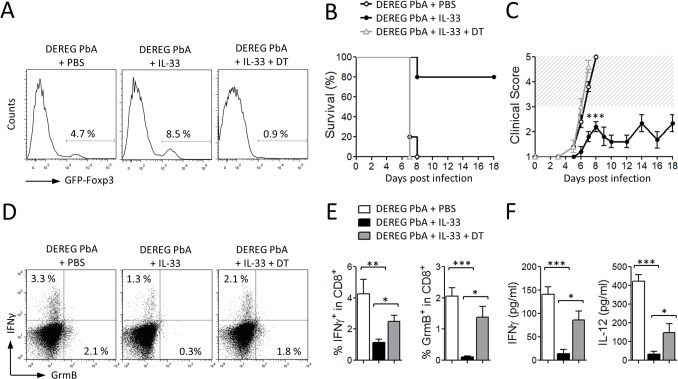
IL-33-mediated protection against ECM is Treg-dependent.DEREG mice were infected with PbA (105 pRBC, i.p.) and daily treated with PBS or IL-33 for 5 consecutive days. Where indicated, mice received diphteria toxin (DT, 1 μg, i.p.) every second day from day 1. (A) Treg depletion was assessed in blood leukocytes on day 5 of infection by FACS on GFP-Foxp3 gated on CD4+ T cells, representative of 5 mice. (B) Survival (Kaplan–Meier survival curves) and (C) clinical score (hatched area indicates ECM related scores) of DEREG mice treated with PBS or IL-33 with or without DT (n = 4–5 per group) are shown. (D-E) Percentage of IFN-γ+ and Granzyme B+ (GrmB) CD8+ T cells in the spleen on day 5 post-infection was determined by FACS. (F) Serum IFN-γ and IL-12 concentrations were determined by ELISA (day 5) (n = 5 per group). Data are mean ± SEM representative of 2 experiments, *P<0.05, **P<0.01, ***P<0.001 by two-tailed ANOVA.